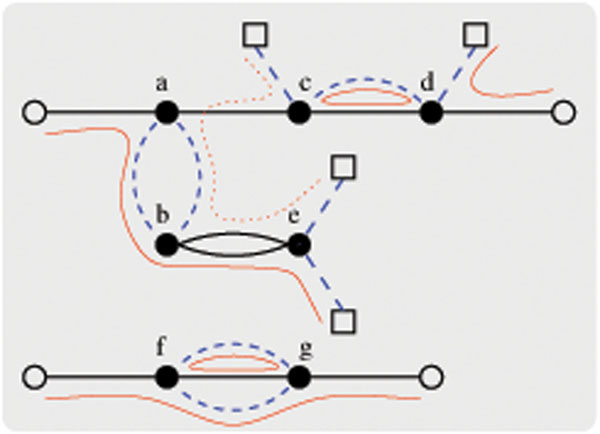
A maximum cycle/path decomposition of the breakpoint graph depicted in Figure1. It consists of two cycles, one AA-path, two AB-paths and one BB-path. Hence, we obtain c = 2, IAA = 1 and IAB = 2 so that dDCJ = 4.